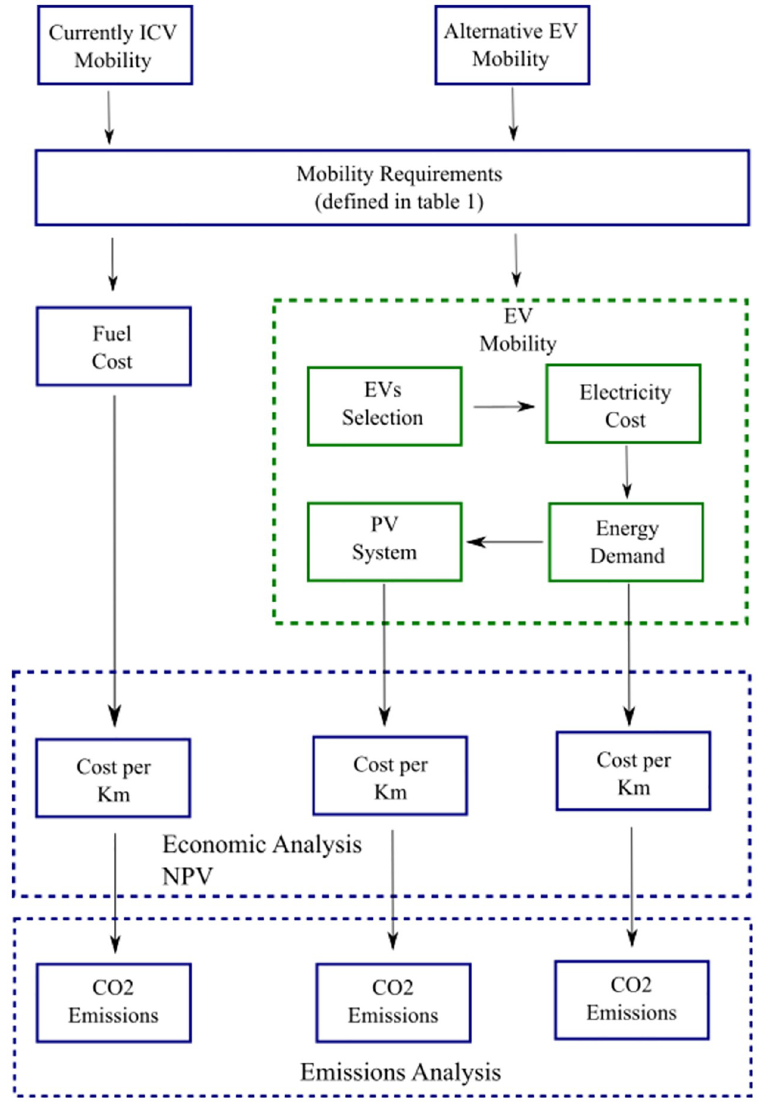
Fig 1. This block diagram illustrates the calculation procedure used in this work. The arrows indicate the following